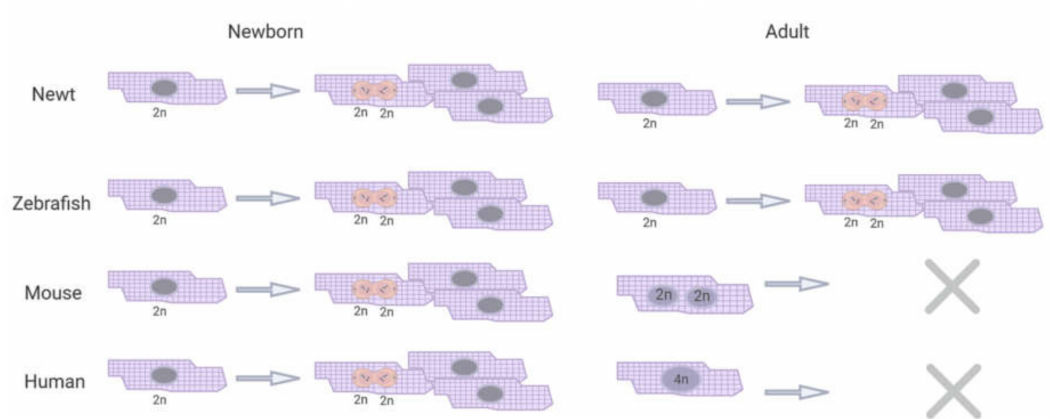
Figure 1. Cardiac regeneration in newts, zebrafish and mammals (mice and human). Upon partial resection of the heart, newts and zebrafish show the development of a blood clot to stop the bleeding. Their cardiomyocytes start to dedi ff erentiate and immune cells, especially macrophages, infiltrate the injured area. The blood clot will gradually become a fibrin clot. Simultaneously, the dedi ff erentiated cardiomyocytes will start proliferating to replace the fibrin clot. After a few days, the resected tissue will be fully replaced by functional heart tissue. Adult mammals, like mouse and human, on the other hand, cannot regenerate their hearts after myocardial injury. They show high levels of cardiomyocyte cell death, necrosis, and apoptosis, and infiltration of neutrophils into the injured area. Some cardiomyocytes will show signs of partial, pathological dedi ff erentiation, but adult mammalian cardiomyocytes cannot proliferate in response to injury. Ultimately, a collagen-rich scar will be formed. The picture is created with BioRender.com.